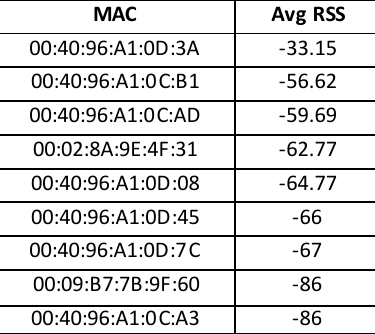
Table 1 – List of signal strengths (dBm) measured at one unknown location from